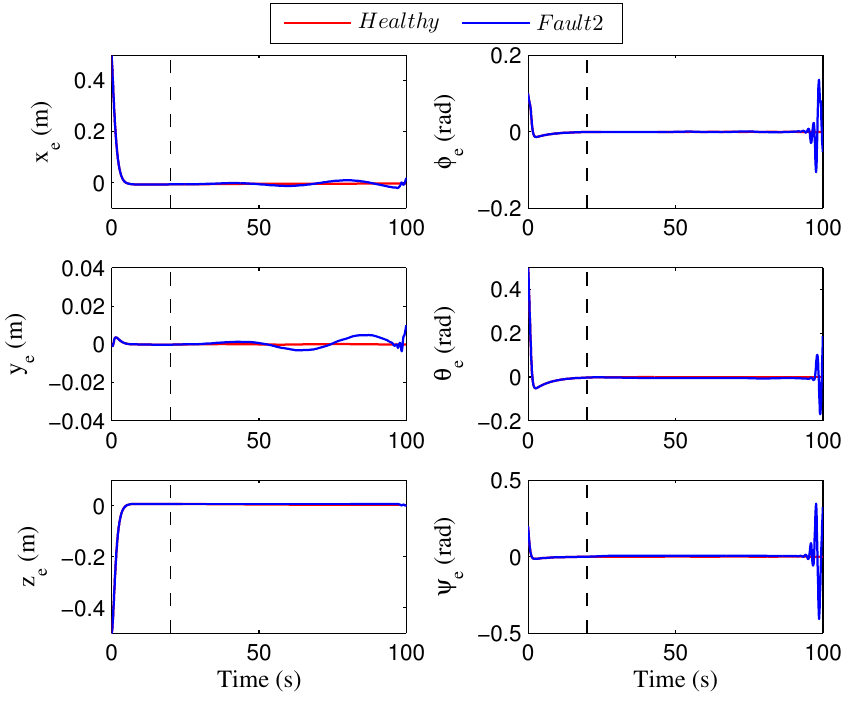
Figure 9. The position and attitude errors with fault 2.